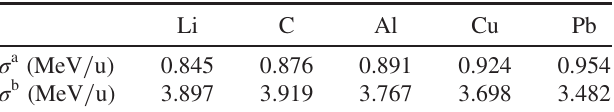
TABLE III. The σ of energy straggling for 1 GeV = u 238 U ions losing the same energy in different target materials, calculated by the code ATIMA [18].